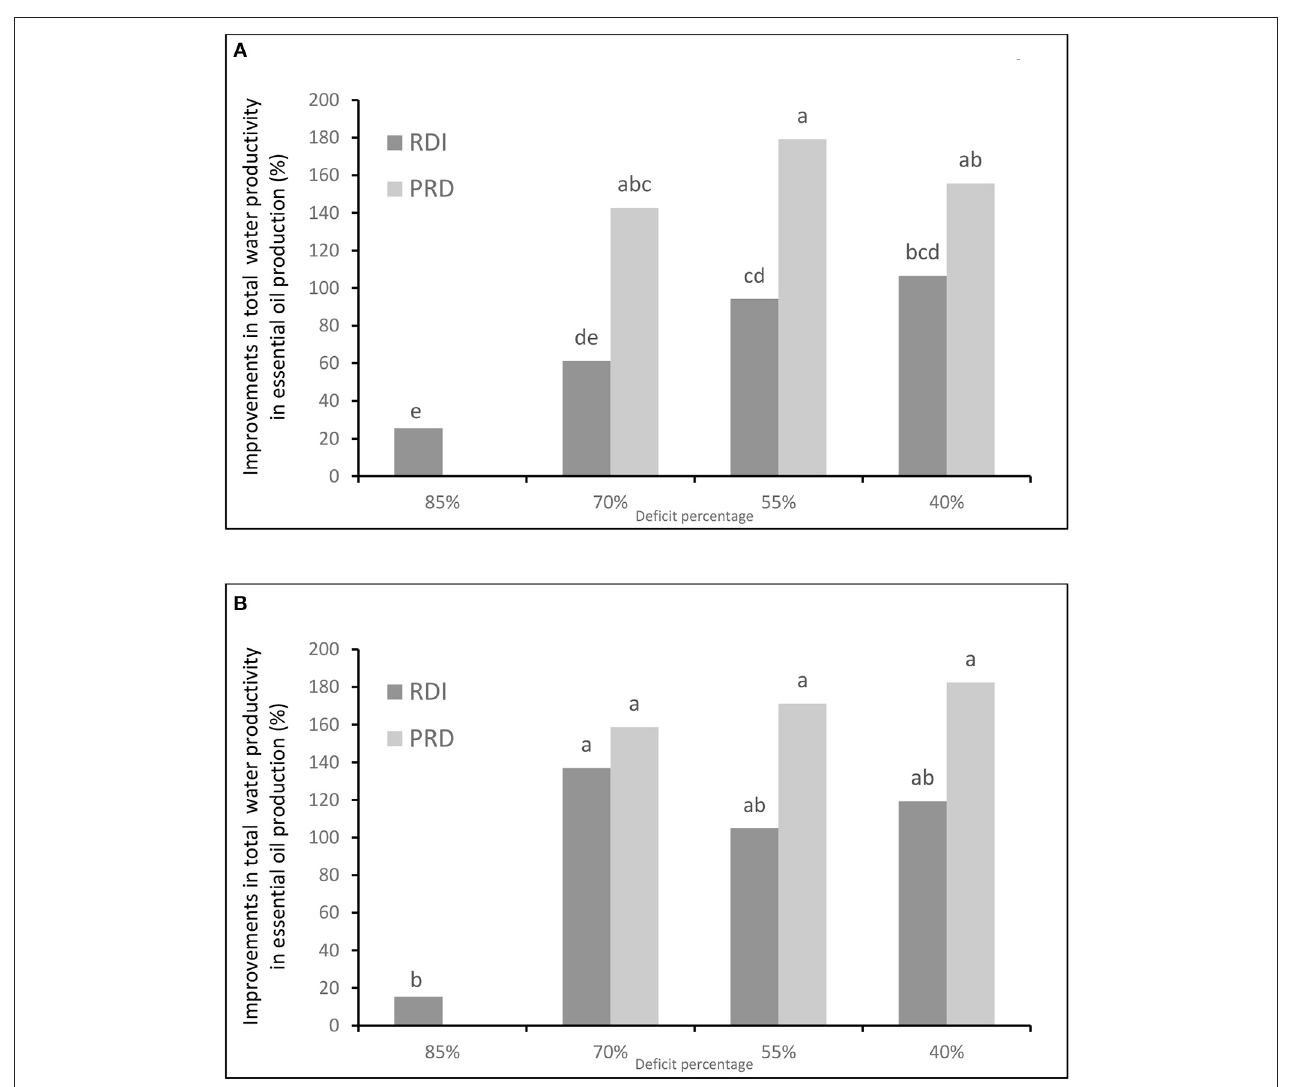
FIGURE 5 | Percentage of improvements in total WP of essential oil production (A) in the first cutting season and (B) in the second cutting season. For a given variable in the chart bars, mean values not sharing common letters are significantly different ( P ≤ 0.05), Duncan